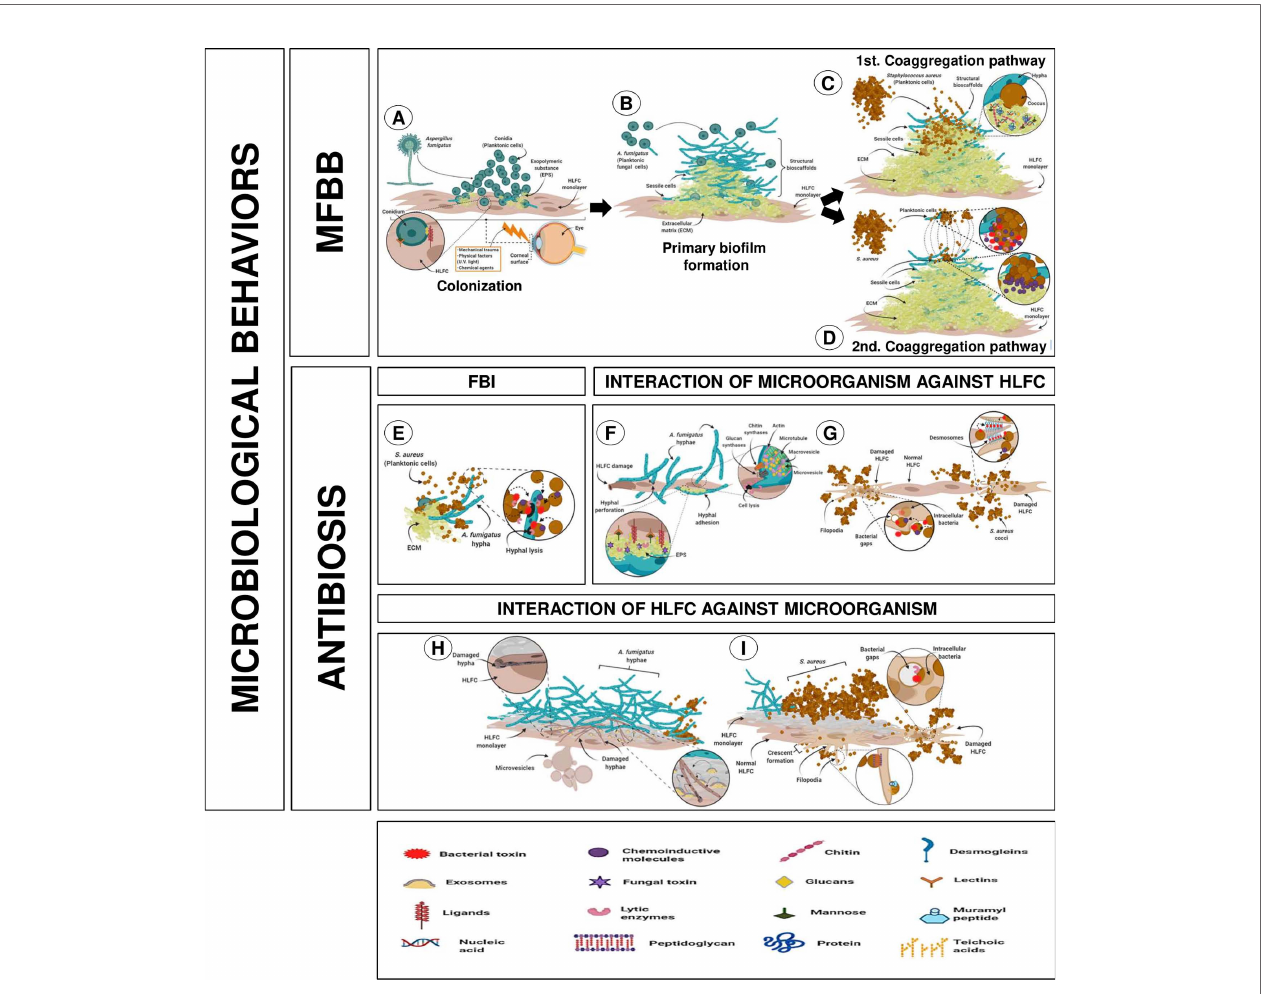
FIGURE 7 | Putative interaction of mixed infection on HLFCs related to eye infections. [MFBB] (A) Colonization of surface HLFCs by planktonic conidia. (B) A primary bio fi lm with rigid and abundant ECM, with planktonic propagules. Co-aggregation pathway could follow two different routes. (C) First pathway: secondary colonizer forms new bioscaffolds of sessile cocci. (D) Second pathway: planktonic bacteria induce co-aggregation over the fungal bio fi lm, reaching the sessile stage. Non-aggregate planktonic cells can migrate to another site. [ANTIBIOSIS] (E) Antagonistic effect from S. aureus over A. fumigatus . MICROORGANISMS AGAINST HLFC. (F) A. fumigatus causes hyphal perforation and EPS secretion, and hyphal adhesion. (G) S. aureus triggers pores and cellular lysis affecting membranes and cytoskeleton, breaking the desmosomes. HLFC AGAINST MICROORGANISMS. (H) HLFC against AF: Fibroblast produces exosomes and microvesicles that could be involved in phagocytic processes. (I) HLFC against SA: Fibroblast projects fi lopodia surrounding the cocci that are accompanied by modi fi cations of the cytoskeleton (crescent formation). For details, see the Results section. Created with